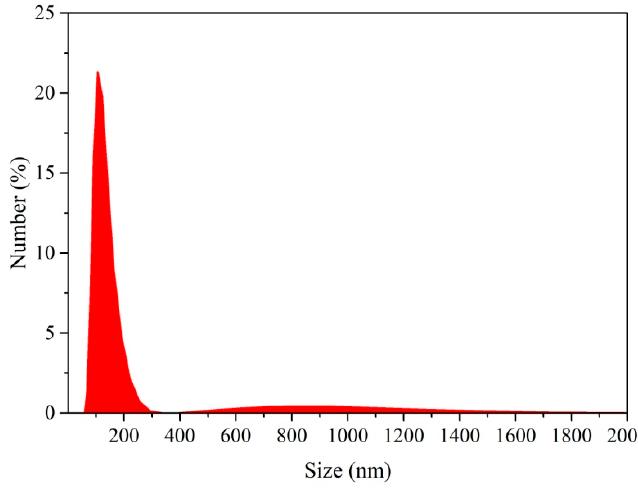
Figure 1. Particle size distribution of cellulose fiber from bengkoang tuber peel.